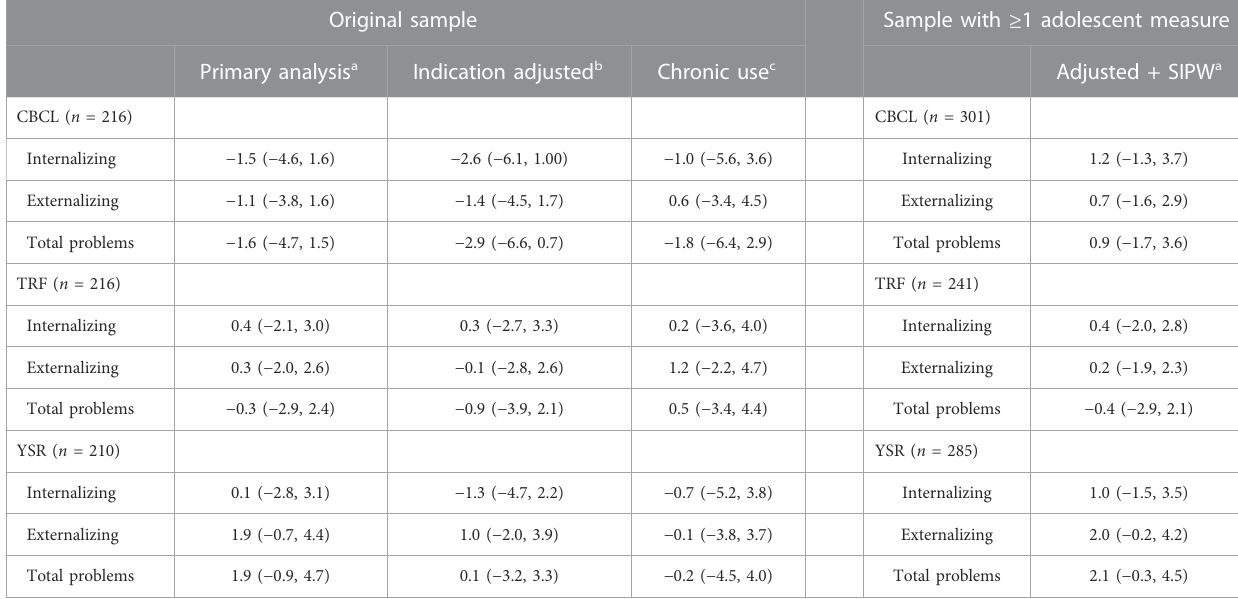
TABLE 4 Mean differences and 95% con fi dence intervals for broadband T-Scores comparing prenatal exposure to acetaminophen to No prenatal exposure, sensitivity